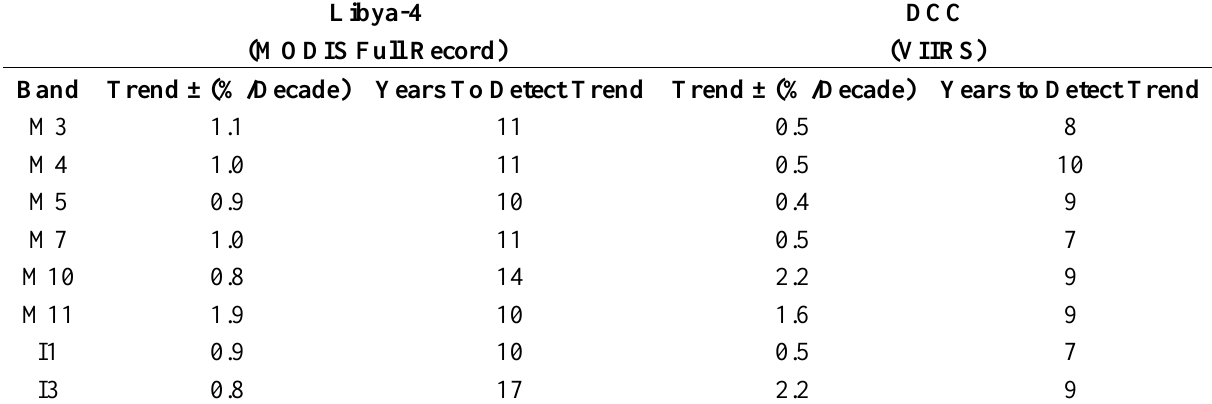
Table 4. The band-specific trends are arbitrarily based on the invariant target standard deviations divided by a decade. The number of years needed to detect the given trend at the 95% confidence level and with 50% probability using Equation (1), where the Libya-4 time series is based on the MODIS full record, and the DCC is based on the VIIRS record is also